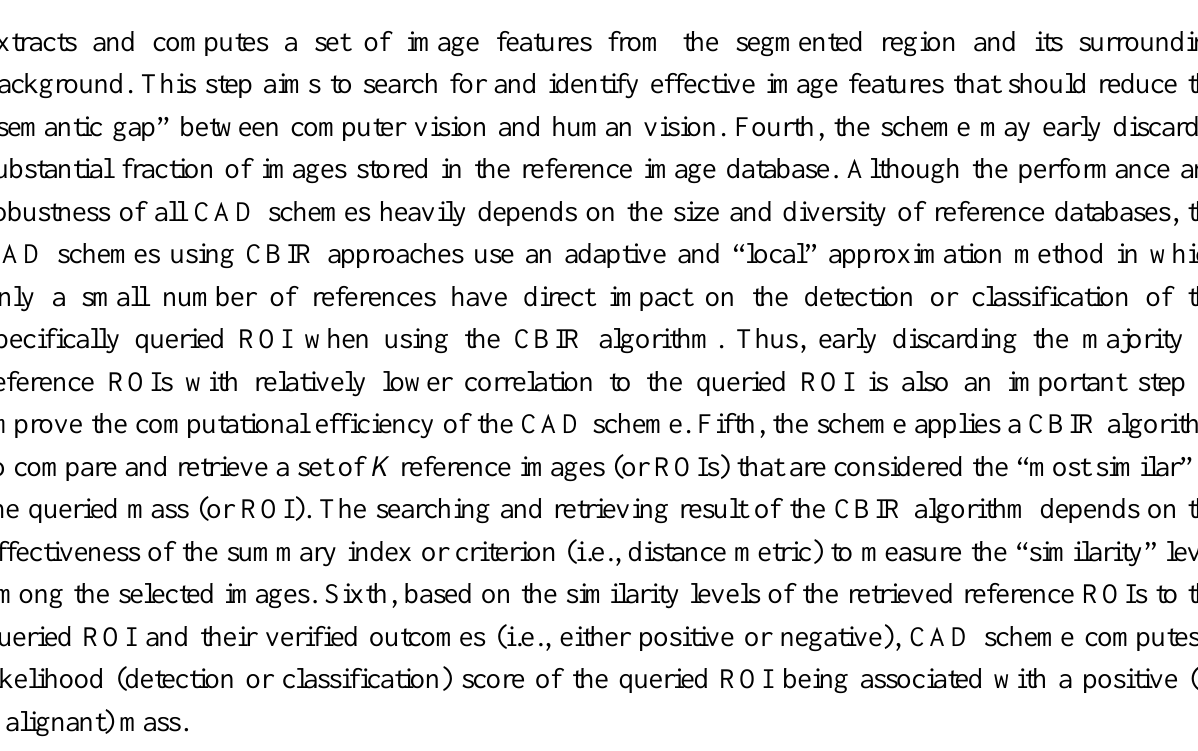
Figure 1: Illustration of a CAD scheme using the CBIR